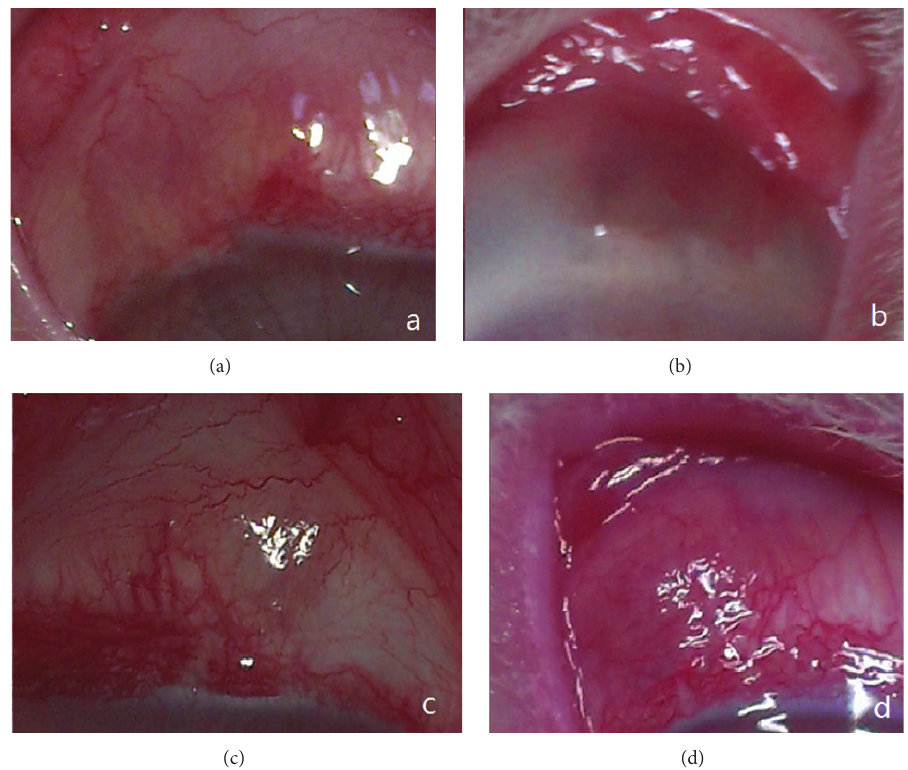
Figure 4: Morphology observation of the filtering bleb 3 months after surgery. (a) Control group. (b) Group 1. Implant under the conjunctiva still can be seen. (c) Group 2. (d) Group 3.